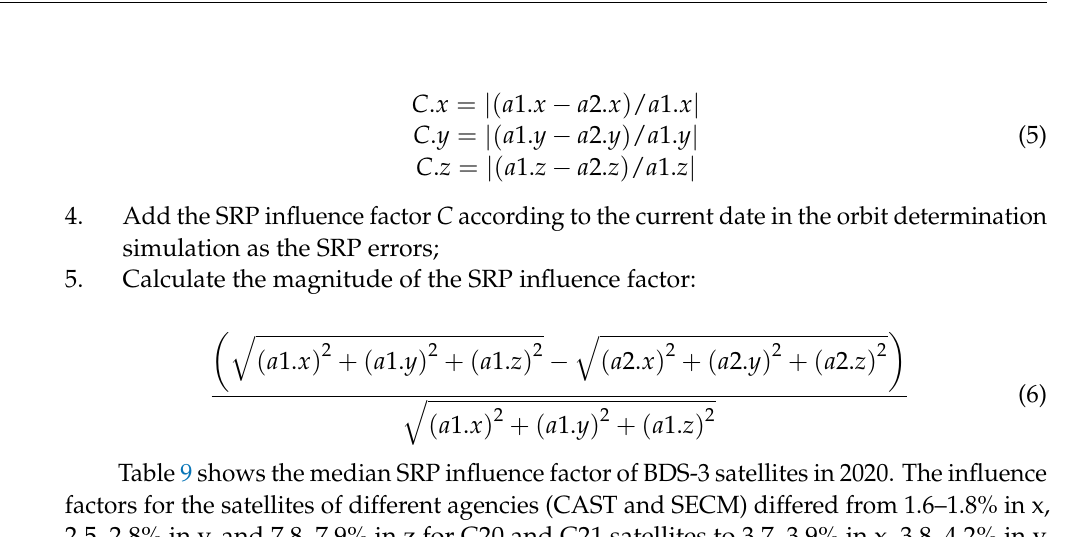
Table 9. The median SRP influence factor of BDS-3 satellites (unit: %). SRP Influence Factor PRN X